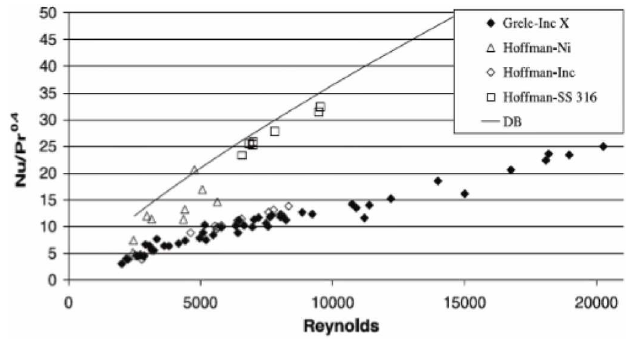
Fig. 1. Experimental results obtained by Grele and Gedeon [2] and Hoffman and Loans [3] compared with Dittus Boelter correlation.